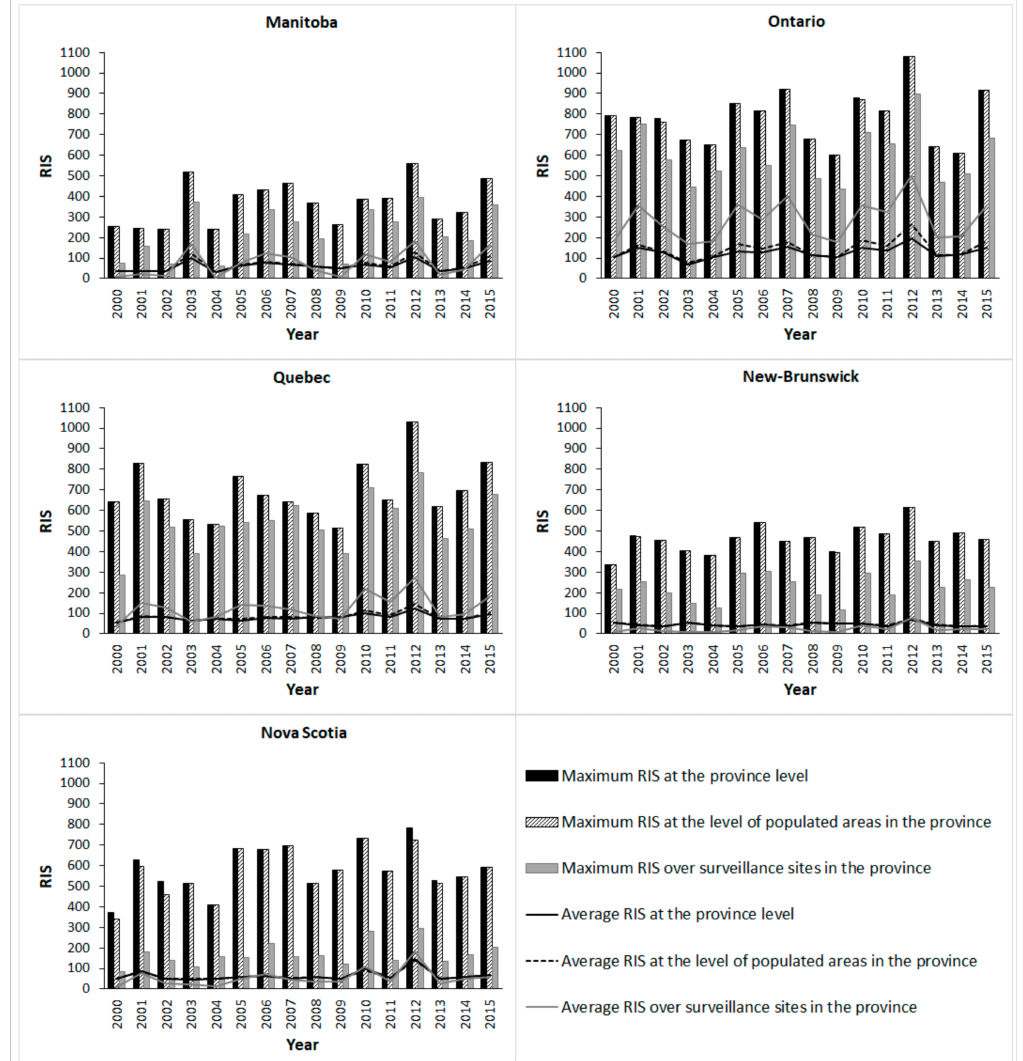
Figure 10. Variation of risk of Ixodes scapularis (RIS) from 2000 to 2015 at province, populated area, and tick surveillance site